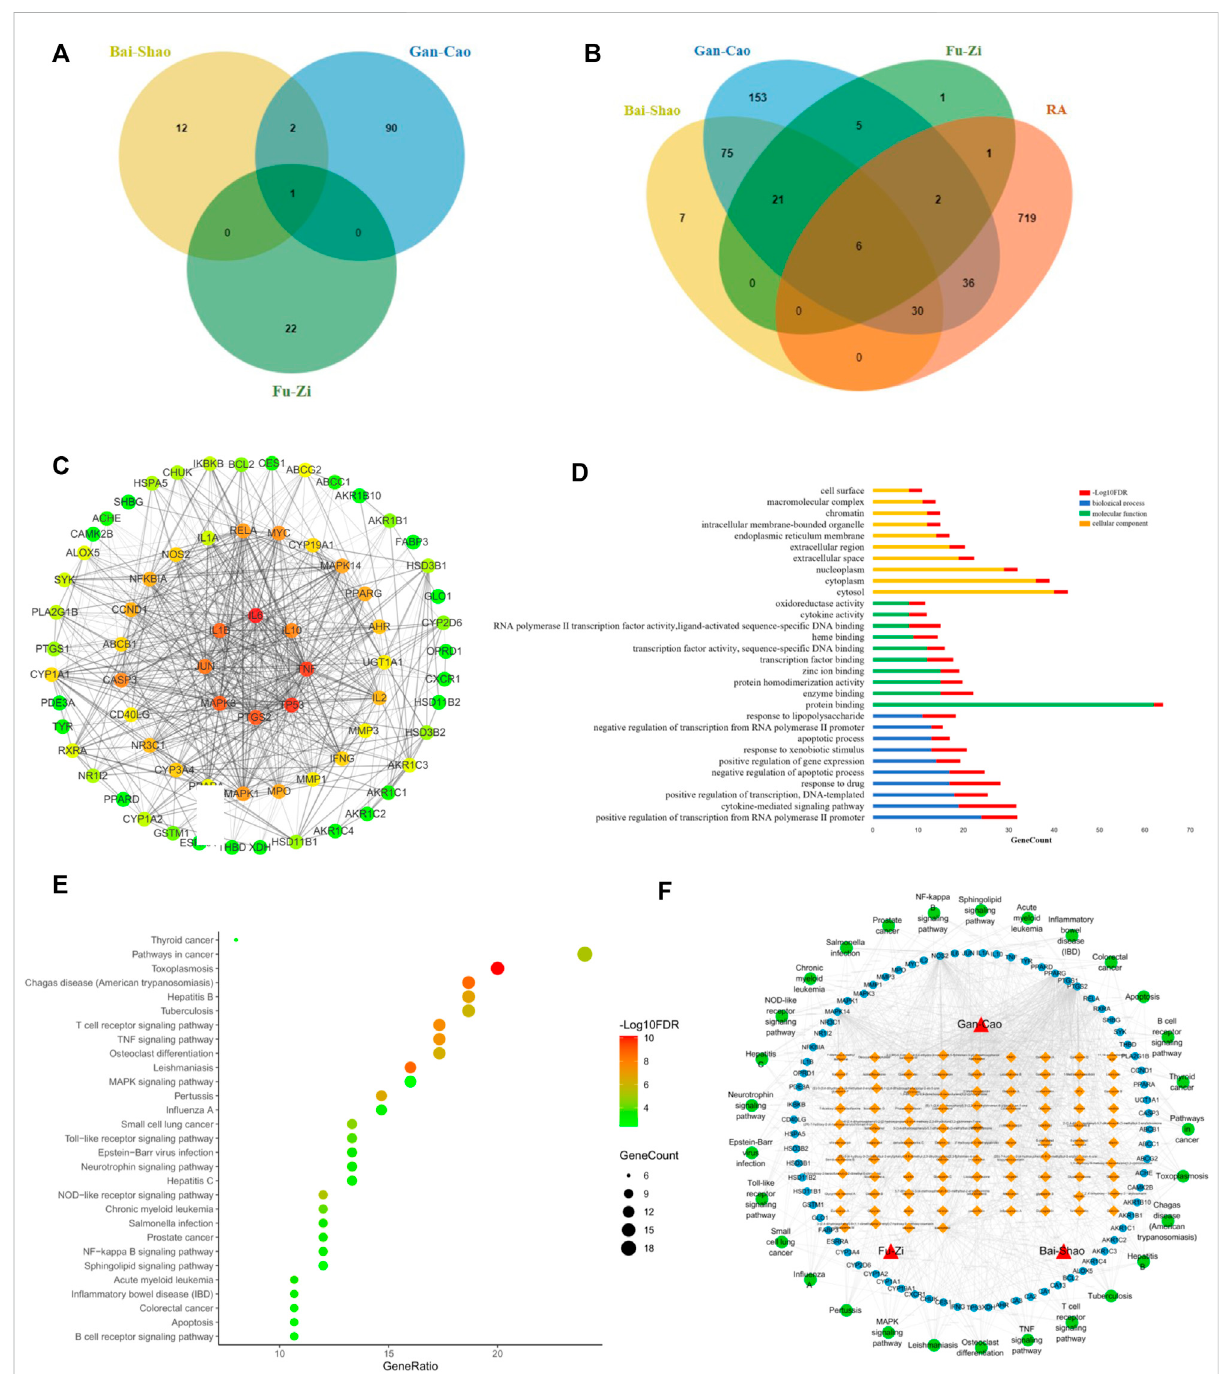
FIGURE 6 Network pharmacology analysis for screening targets and pathways of SGFD. Venn diagram of (A) . Active compounds in SGFD and (B) . Common target of SGFD and RA. (C) . PPI network of common targets. The target is represented by a circle node. The color of node changed from green to red corresponds to a degree from small to bigger. The thickness of the edge and the combined score value between the protein have a positive correlation. (D) . GO enrichment analysis for common targets. (E) . KEGG pathway analysis for common targets. (F) . Herb-Compound- Target-Pathway network. The red triangles represent the herbal medicines; the yellow squares represent the active chemical compounds of SGFD; thebluedotsrepresentthekeytargetsinthetreatmentofRAwithSGFD;thegreendotsrepresentthepathwaysbasedonenrichmentanalysisofkey